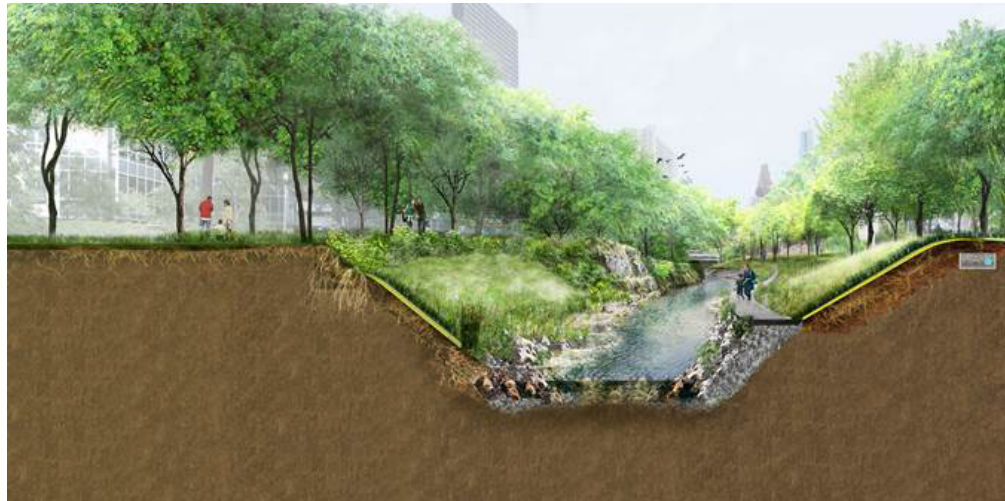
Figure 3. Waller Creek Cross-Section. (Source: Michael Van Valkenburgh Associates,